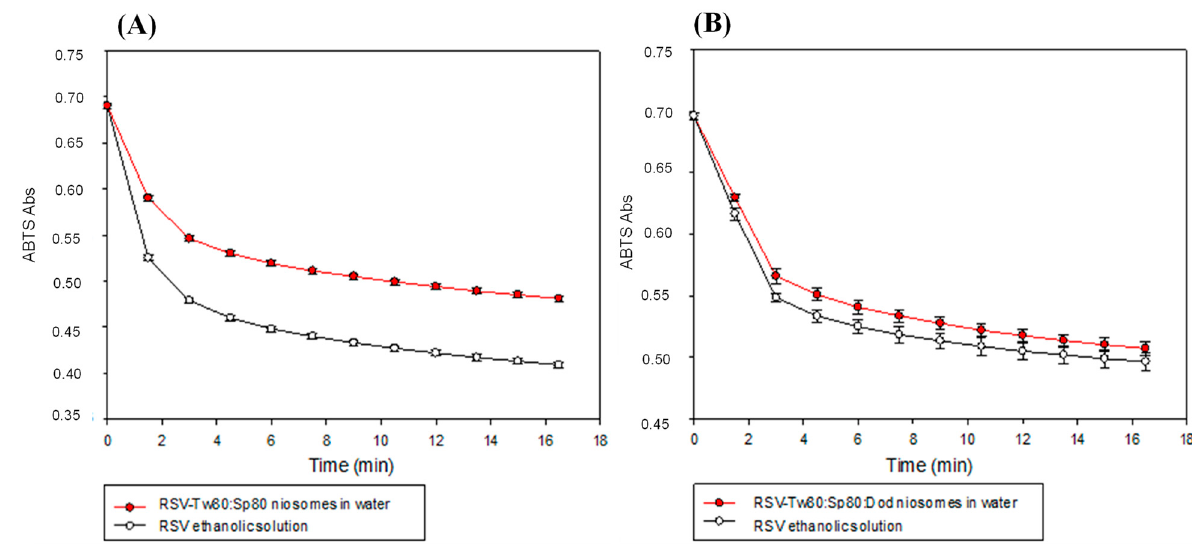
Figure 3. ABTS absorbance vs. time for ( A ) Tw80:Sp80 and ( B ) Tw80:Sp80:Dod niosomes, loaded with RSV, and a control solution in ethanol. ( A ) [ RSV ] = 4 μ M, ( B ) [ RSV ] = 3 μ M. Error bars correspond to standard deviations of at least three determinations.